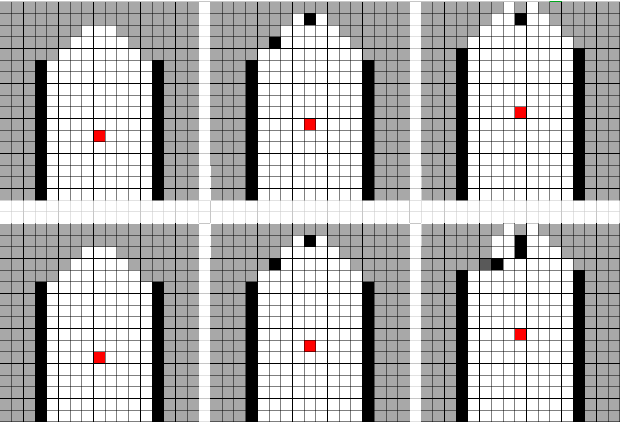
Figure 3. Simulation comparisons of map updating between the proposed strategy and the existing one.